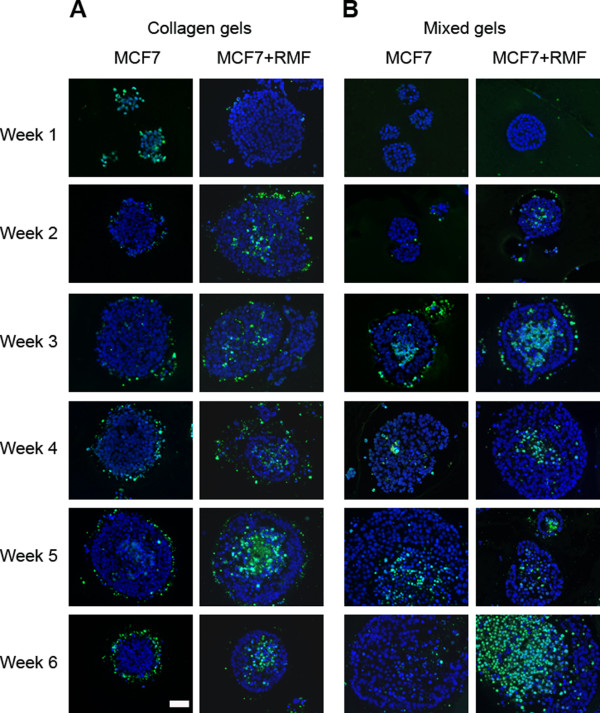
Apoptosis in epithelial structures. Cell death was assessed using the TUNEL assay. Blue: DAPI, Green: apoptotic cells. Scale bar: 50 μm